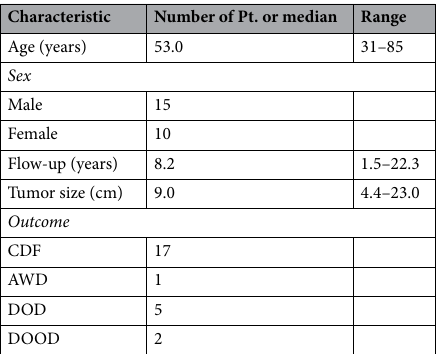
Table 1. Clinical characteristics of 25 patients with myxoid liposarcoma. CDF Continuous disease free, AWD Alive with disease, DOD Dead of disease, DOOD Dead of other disease.